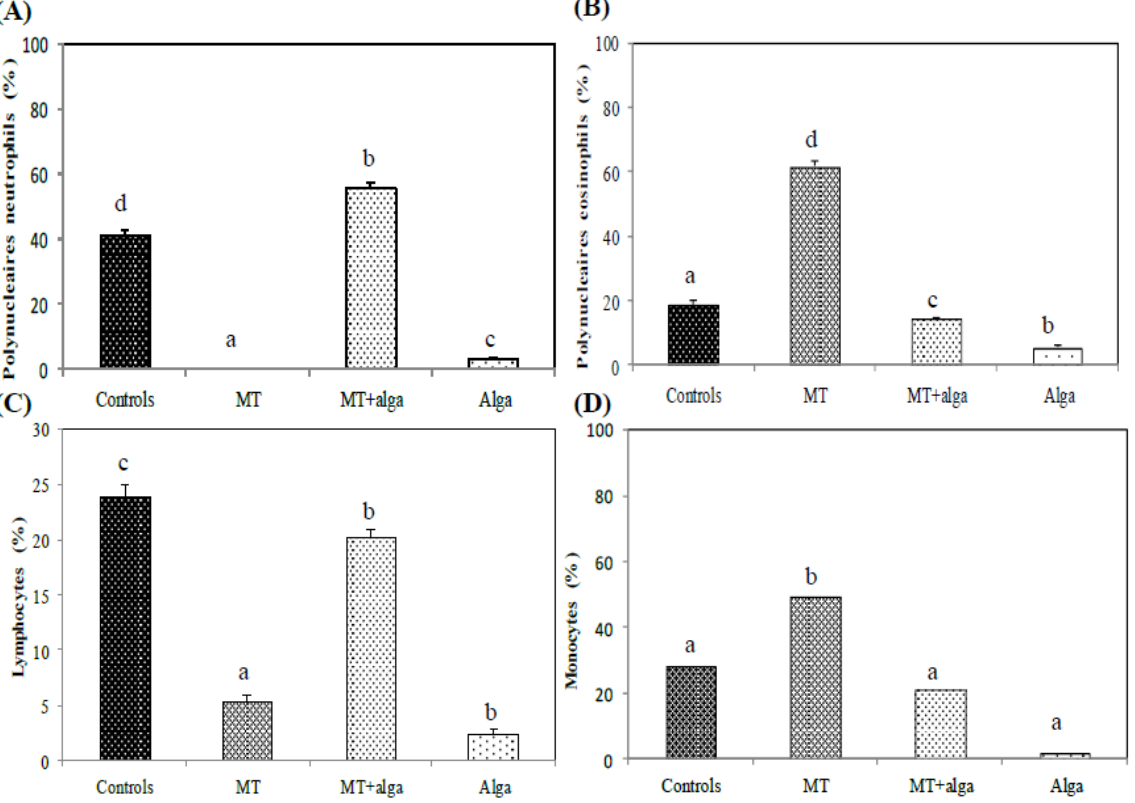
Figure 2. Numeration of White Blood Cells formula in different experimental groups of rats. ( A ) Polynucleaires neutrophils; ( B ) Polynucleaires eosinophils; ( C ) Lymphocytes; ( D ) Monocytes. a,b,c indicate significant differences between experimental groups ( p < 0.05).